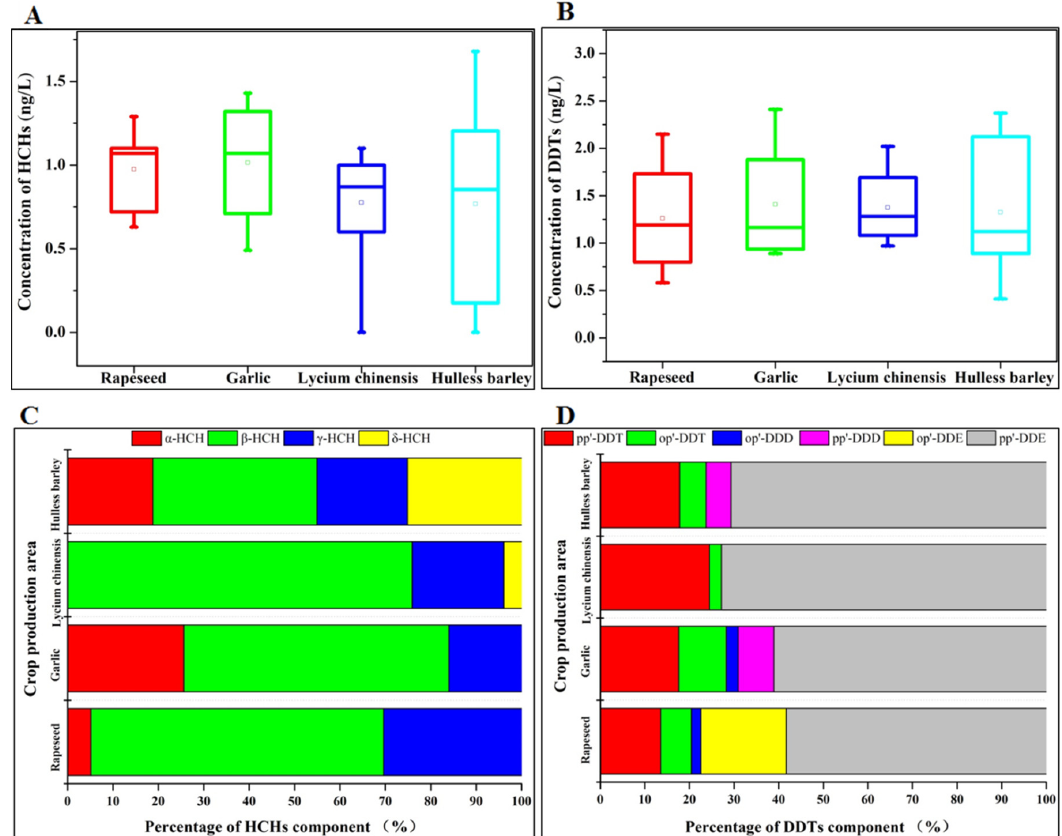
Figure 2. Residue status of organochlorine pesticides (HCHs and DDTs) in surface water samples from four typical crop areas. ( A ) Residue Levels of HCHs; ( B ) Residue Levels of DDTs; ( C ) Residue composition of HCHs; ( D ) Residue composition of DDTs.